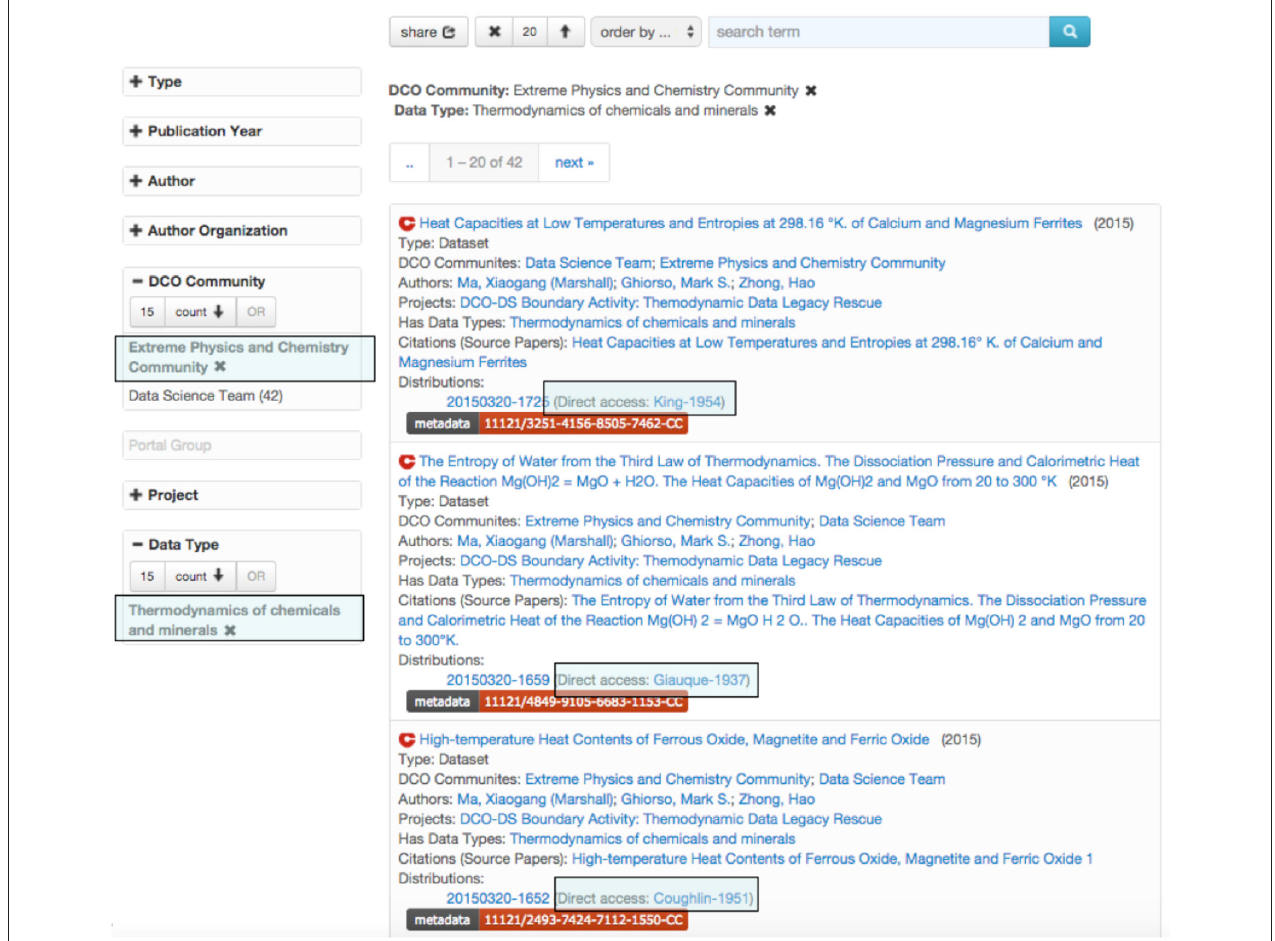
FIGURE 6 | Accessing rescued thermodynamic datasets in the DCO dataset browser. Rectangles indicate key selection concepts and returned results (the datasets